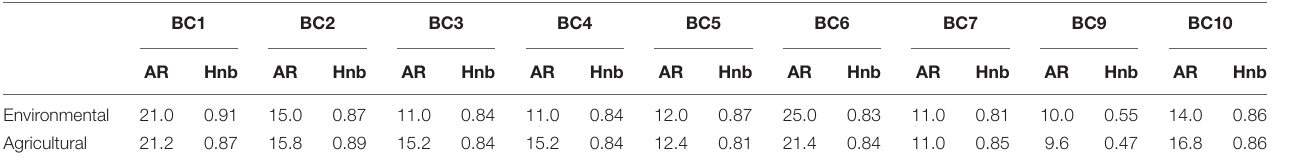
TABLE 3 | Allelic richness (AR) and unbiased gene diversity (Hnb) of environmental and agricultural strains of B. cinerea , at each of the nine microsatellite loci (corrected for the smallest sample size: 100). BC1 BC2